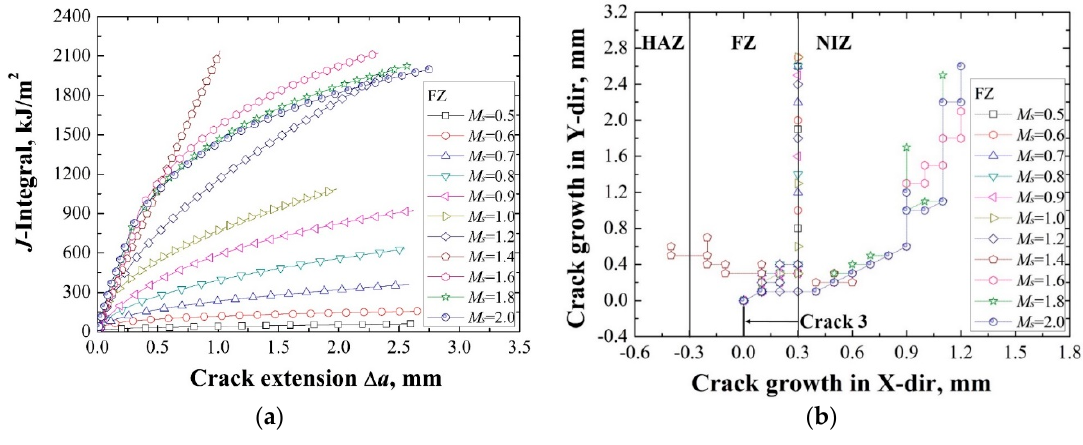
Figure 6. The J – R curves ( a ) and the crack growth paths ( b ) at different strengths of FZ.